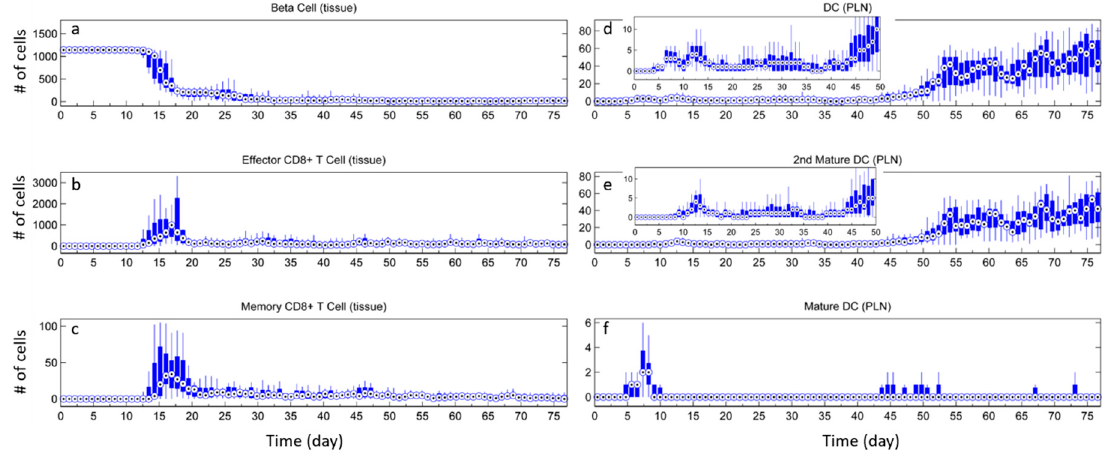
Figure 4. Simulation results for case without Tregs (case I). There are no initial Tregs and also no conversion ability of CD4 + T cells. The number of ( a ) β cells, ( b ) effector CD8 + T cells, ( c ) memory CD8 + T cells- in pancreatic tissue are shown on the left column. The number of ( d ) total DCs, ( e ) 2nd mature DCs, ( f ) mature DCs in PLN are shown on the right column. Inserts (number of cells vs. time) show small change of cell number in the bottom figures. t = 0 days correspond to 3-week age of mouse.